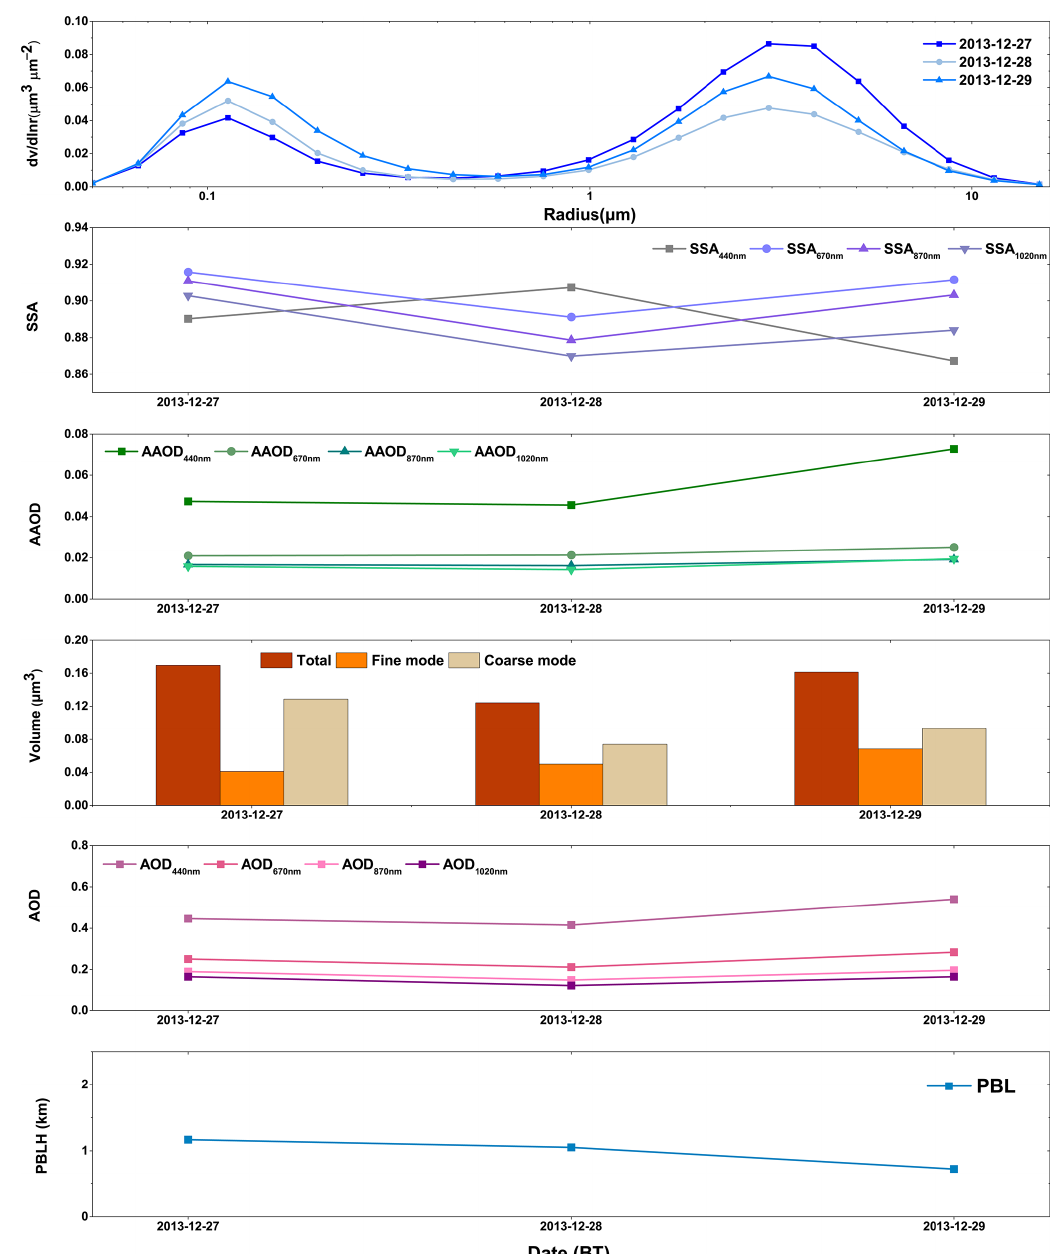
Figure 14. Daily averaged variation in aerosol optical properties and the PBLH in Hangzhou during 27–29 December 2013.